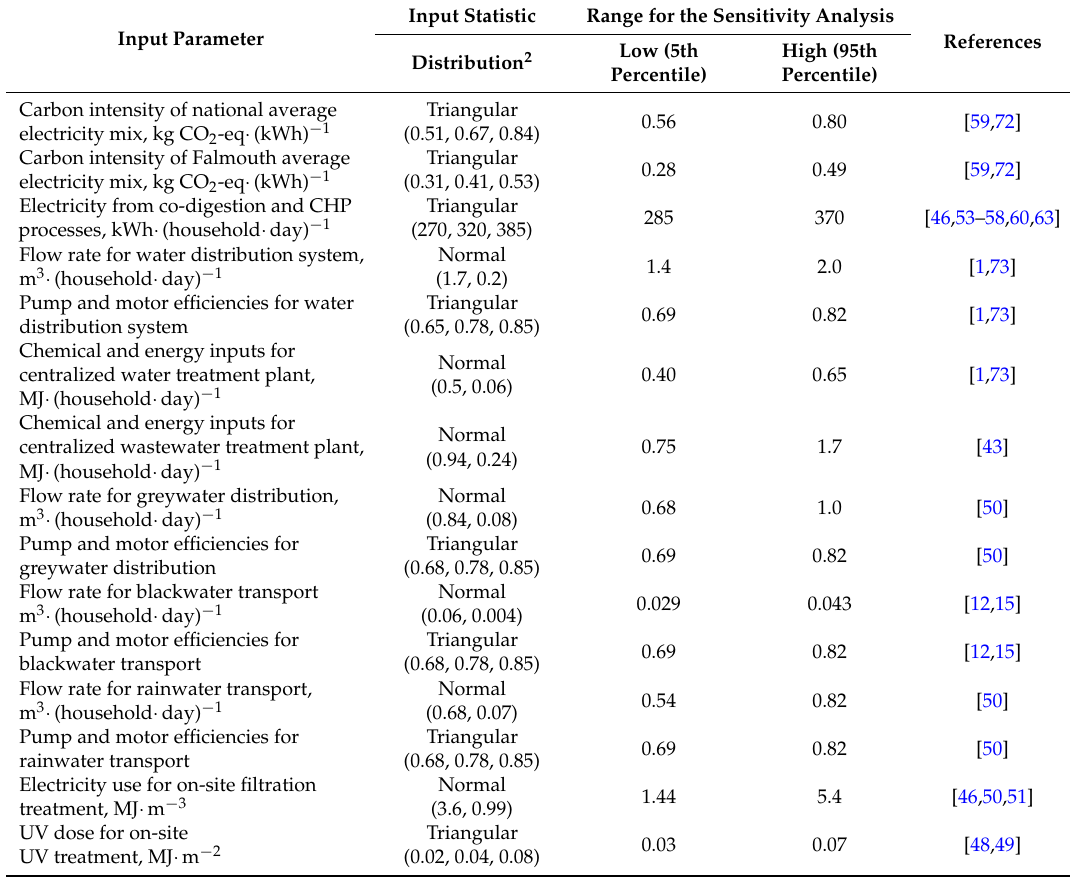
Table 1. Key life cycle inventory input parameters 1